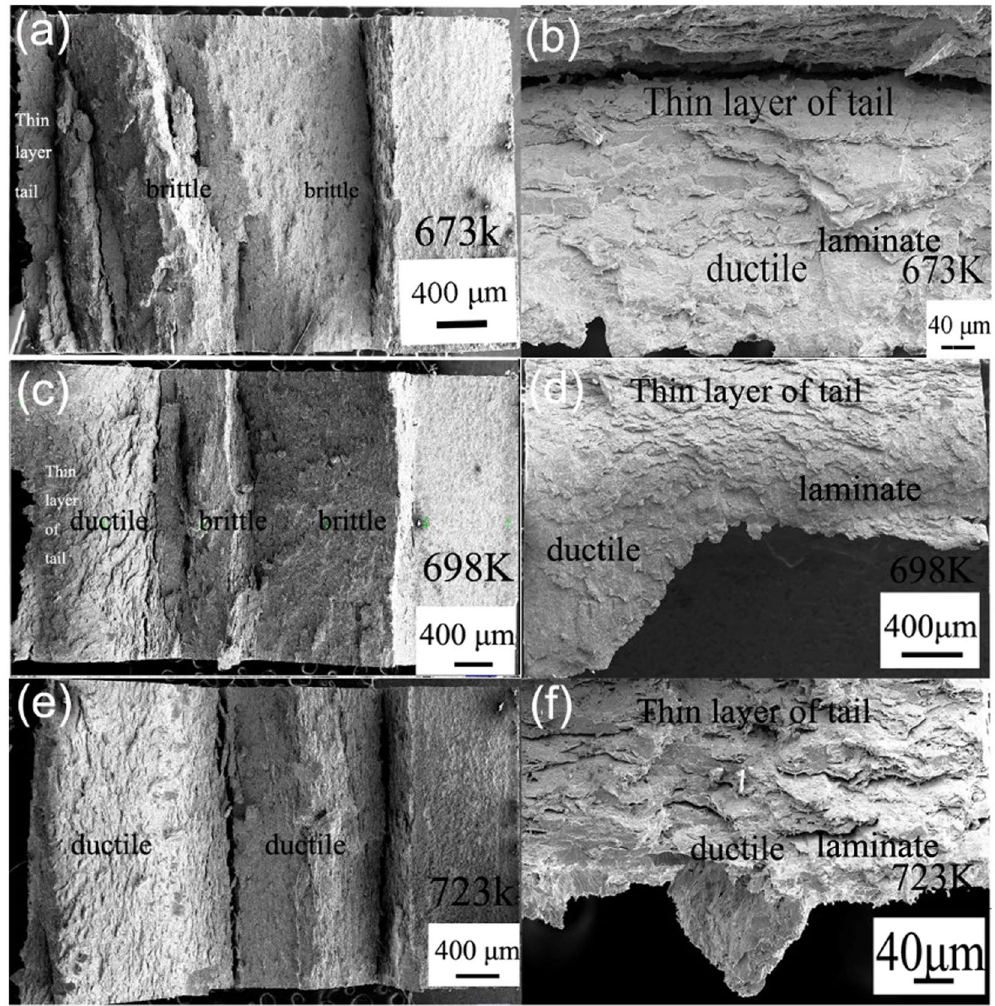
Figure 9. Fracture surfaces of the Charpy impact for the ϕ 1.5 mm ZrO 2 ball SMATed WL10; ( a , b ) 673 K, ( c , d ) 698 K, and ( e , f ) 723